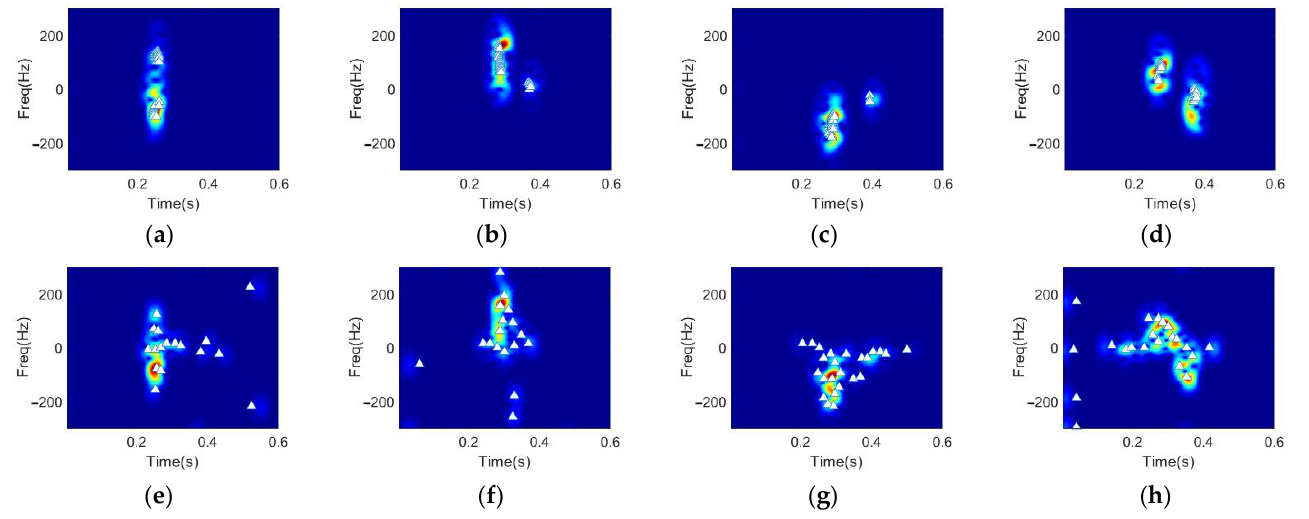
ping fingers, ( b ) flipping fingers, ( c ) clenching hand, ( d ) clicking fingers.